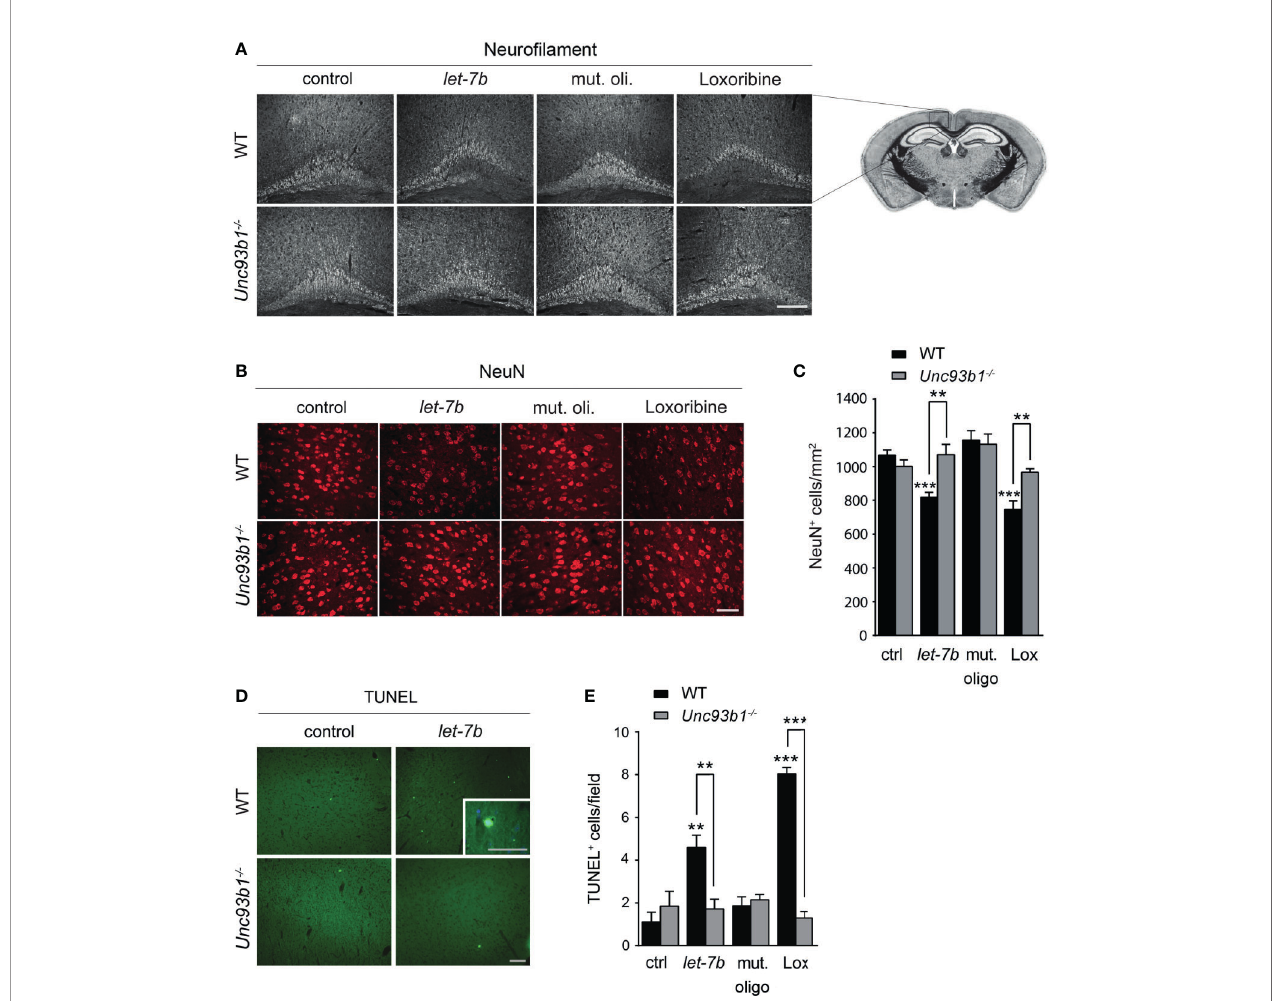
FIGURE 6 | Neurodegeneration triggered by intrathecal let-7b and loxoribine requires UNC93B1 expression. We intrathecally injected 10 m g of let-7b , 10 m g of mutant oligoribonucleotide, 136 µg loxoribine, or PBS (control) into C57BL/6 (WT; let-7b, n = 7; mut. oligo, n = 6; loxoribine, n = 6; PBS, n = 4) or Unc93b1 -/- ( let- 7b , n = 5; mut. oligo, n = 6; loxoribine n = 6; PBS, n = 4) mice. After 3 d, brain sections were immunolabeled with neuro fi lament (A) and NeuN (B) antibodies, and representative images of the pericallosal area and cerebral cortex, respectively, are shown [scale bar, 200 µm in (A) ; 50 µm in (B) ]. (C) Density of neurons in the cerebral cortex of WT and Unc93b1 -/- mice was assessed quantifying NeuN-positive cells. Brain sections described above were stained with TUNEL assay (D) , and TUNEL-positive cells in the cerebral cortex were quanti fi ed (E) . (C, E) One-way ANOVA was used to determine statistical signi fi cances across all tested conditions (C) p < 0.0001 over WT and p = 0.1232 over Unc93b1 -/- ; (E) p < 0.0001 over WT and p = 0.571 over Unc93b1 -/- ]. Unpaired Student ’ s t -test was used to assess signi fi cant differences between pairs (indicated group vs. control, ctrl; WT vs. Unc93b1 -/- ; ** p < 0.01; *** p < 0.001). Scale bar, 100 µm (overview D ) and 50 µm (inlay in D